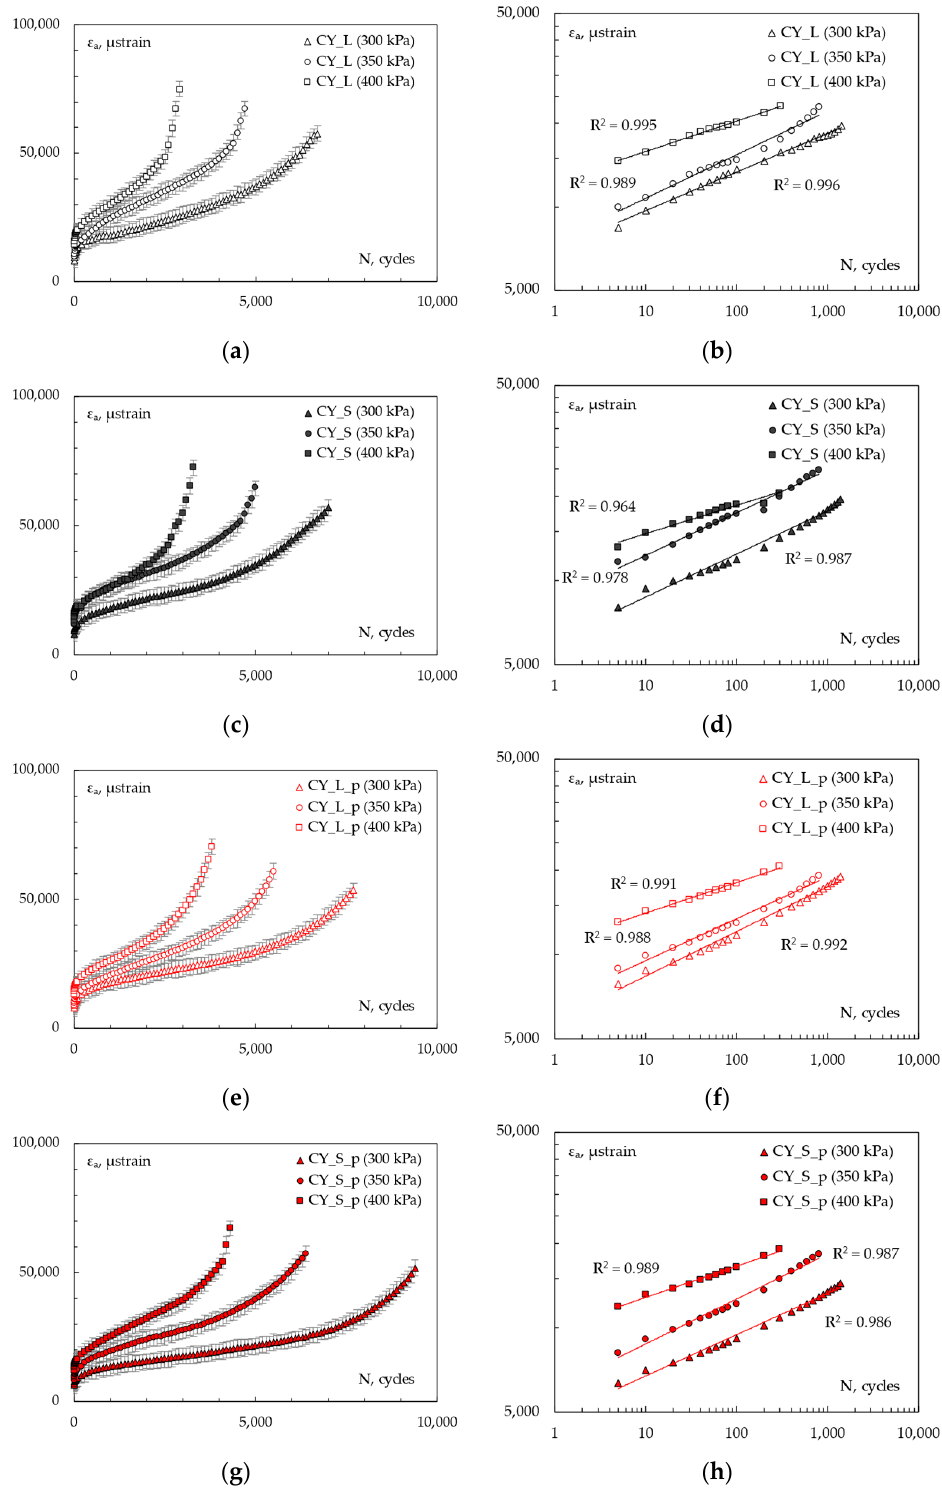
Figure 8. Cumulative axial strain evolution. Standard representation and log–log plot for CY_L ( a , b ), CY-S ( c , d ), CY_L_p ( e , f ), CY_S_p ( g , h ).